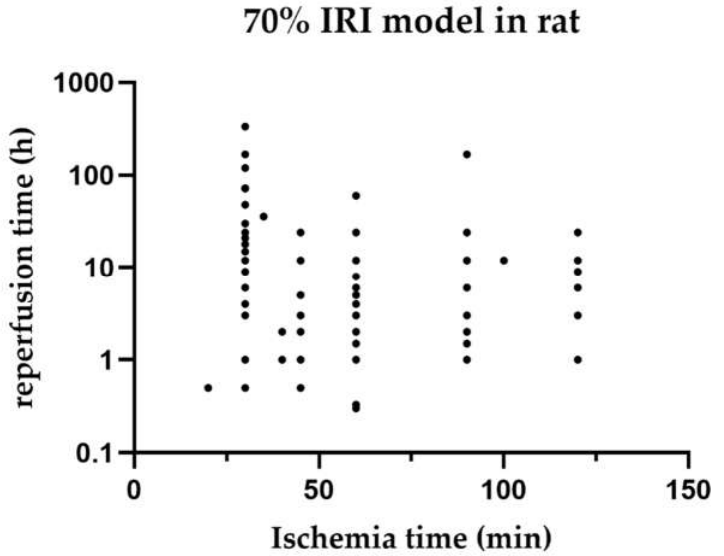
Figure 2. Distribution of reperfusion times compared with their ischaemia times in 70% ischaemia models in rats. Studies with various reperfusion times are listed for each individual time point. Time points are listed regardless of the survival time of